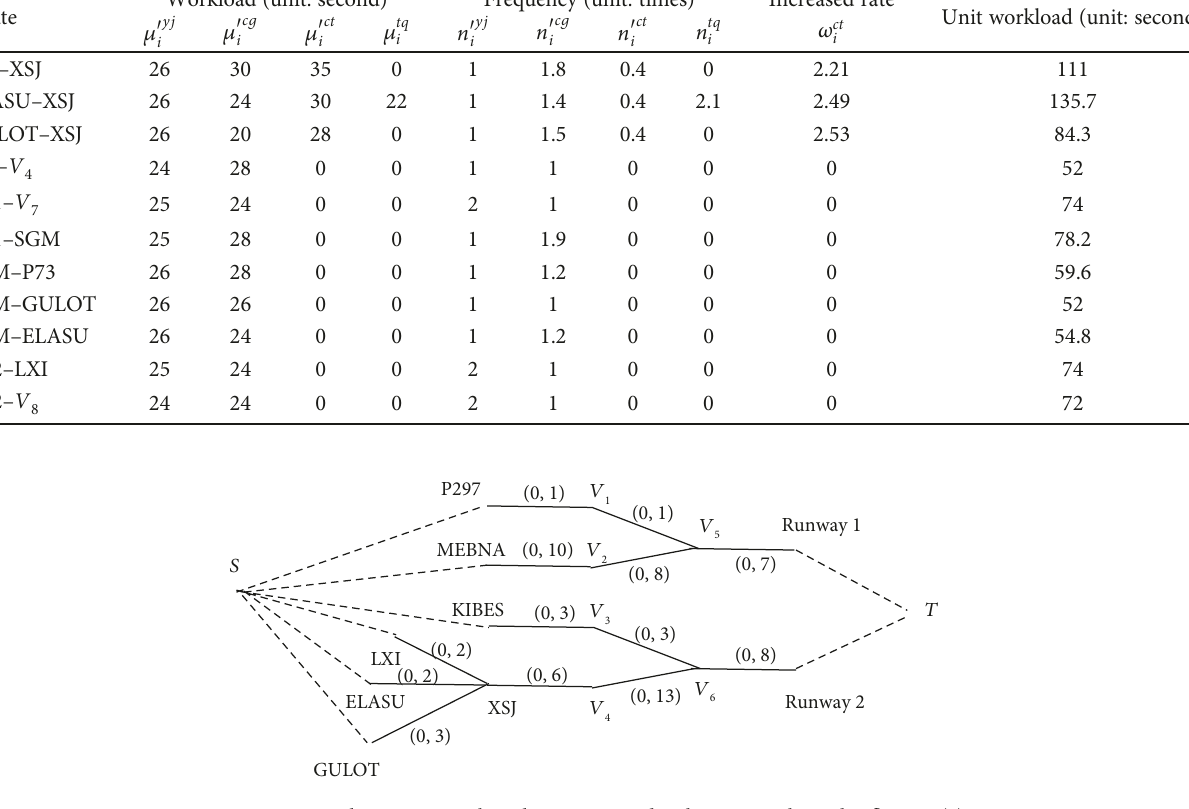
Figure 7: Arrival route network with capacity under the meteorological in fl uence (a).